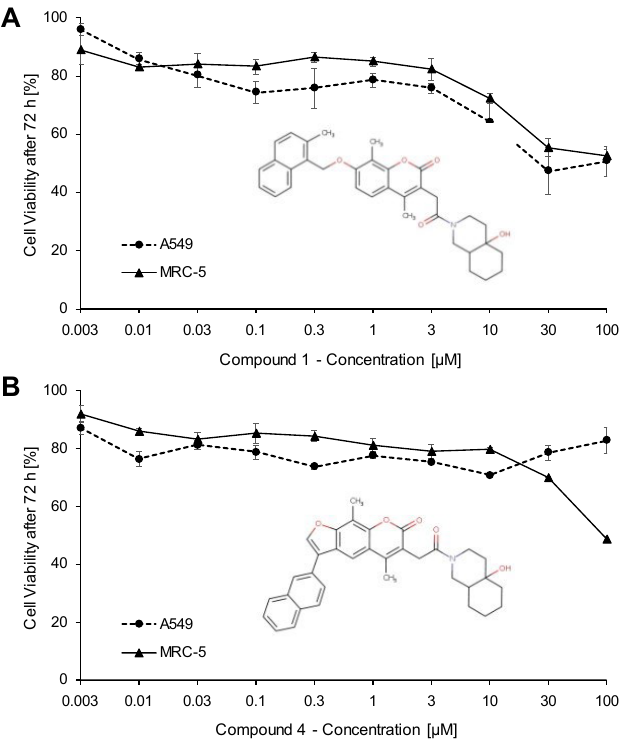
Figure 9. Cytotoxicity of compounds ( 1 ) ( A ) and ( 4 ) ( B ) towards A549 and MRC5 cells as determined by the resazurin assay. The dose-response curves represent the mean ± SD of three independent experi-ments for each cell line with each six parallel measurements.